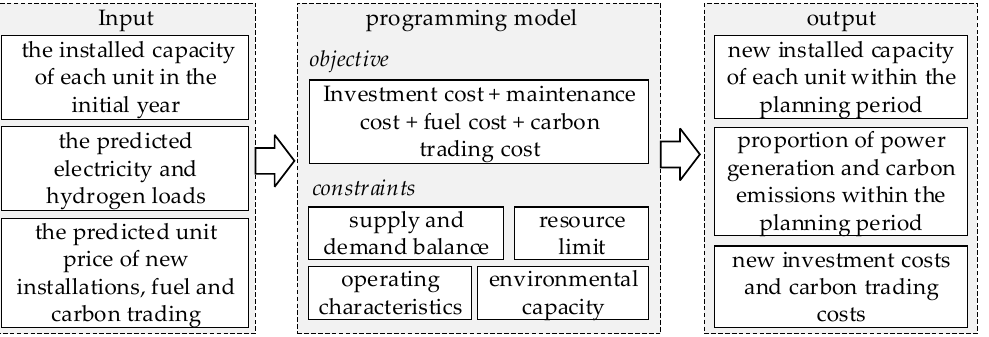
Figure 3. The planning